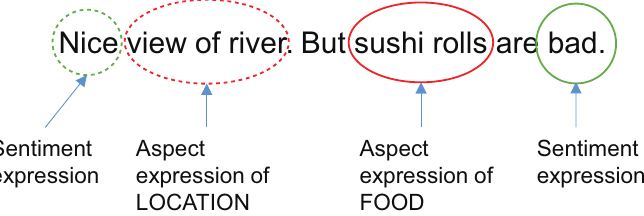
Figure 1. An example of aspect-based sentiment analysis (ABSA). Sentiment expressions such as “nice” or “bad” appear near their related aspect expressions “view of river” and “sushi rolls,”